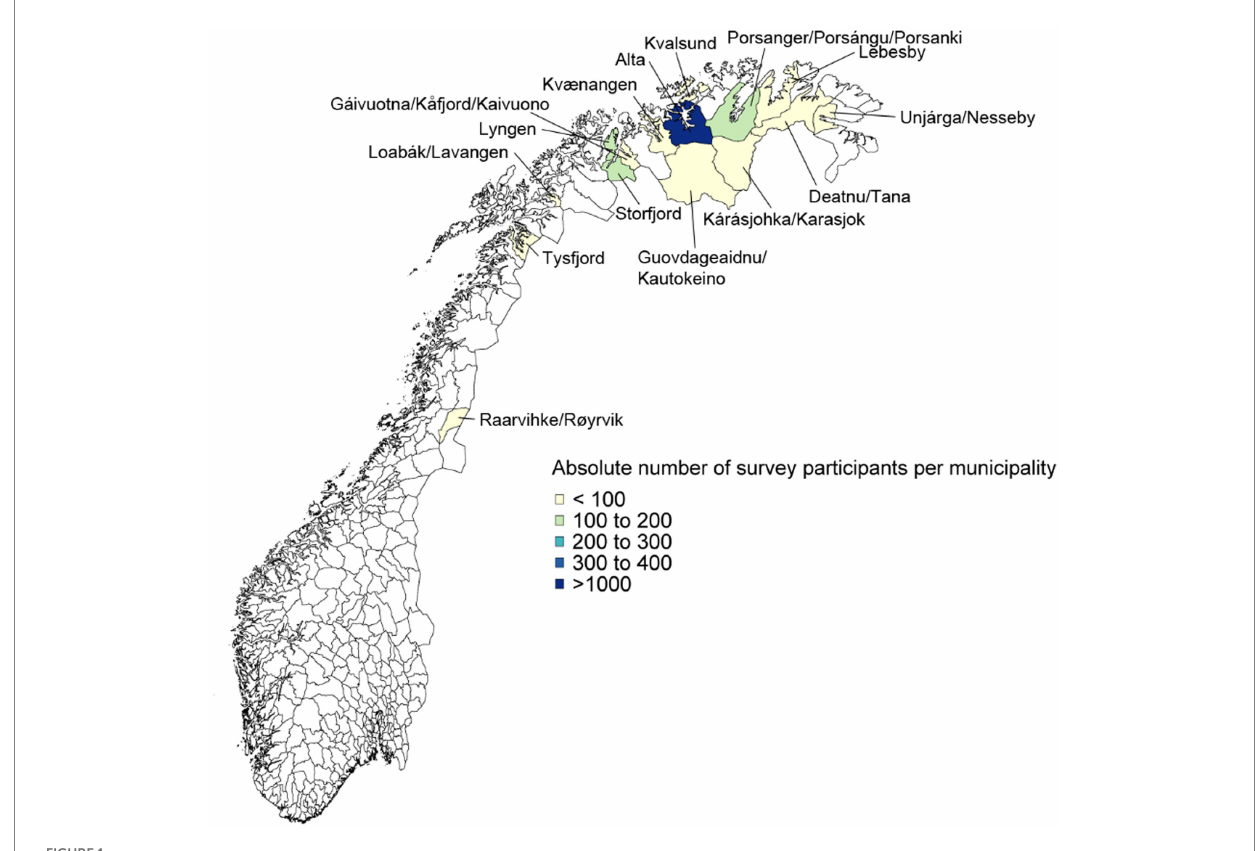
FIGURE 1 Respondent numbers in